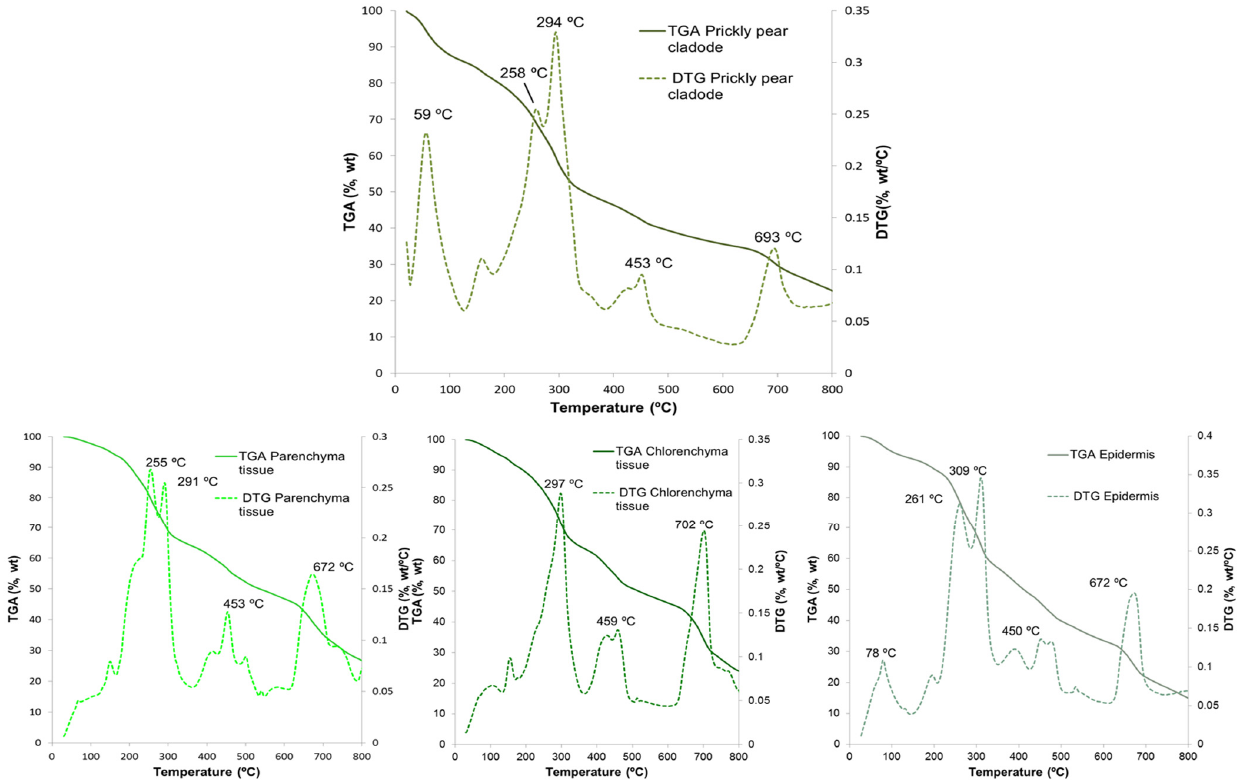
Figure 4. TGA/DTG analyses of whole prickly-pear cladode biomass ( up ) and its constituent tissues (from ( left ) to ( right ): parenchyma, chlorenchyma, and epidermis) in flowing